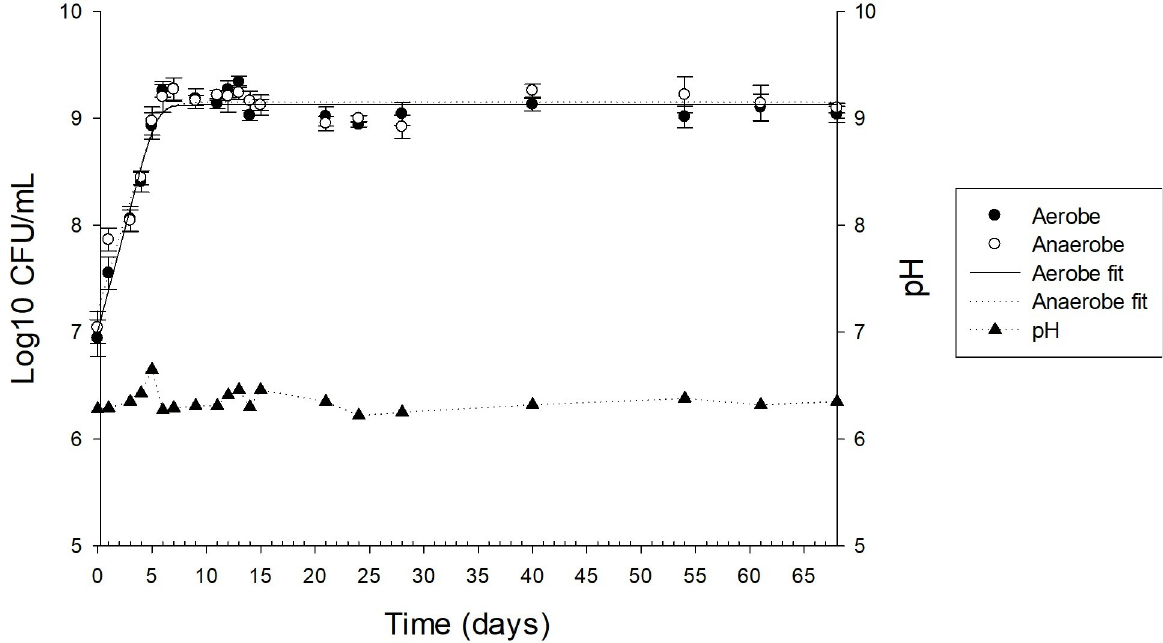
Fig 1. Nile tilapia ( Oreochromis niloticus )-derived continuous-flow competitive exclusion culture bacterial cell counts for aerobes ( ● ) and anaerobes ( � ), and fitting data to DMFit online-version in the primary y-axis, and pH ( ▲ ) in the secondary y-axis. Each symbol represents a mean ± SD of triplicate results.